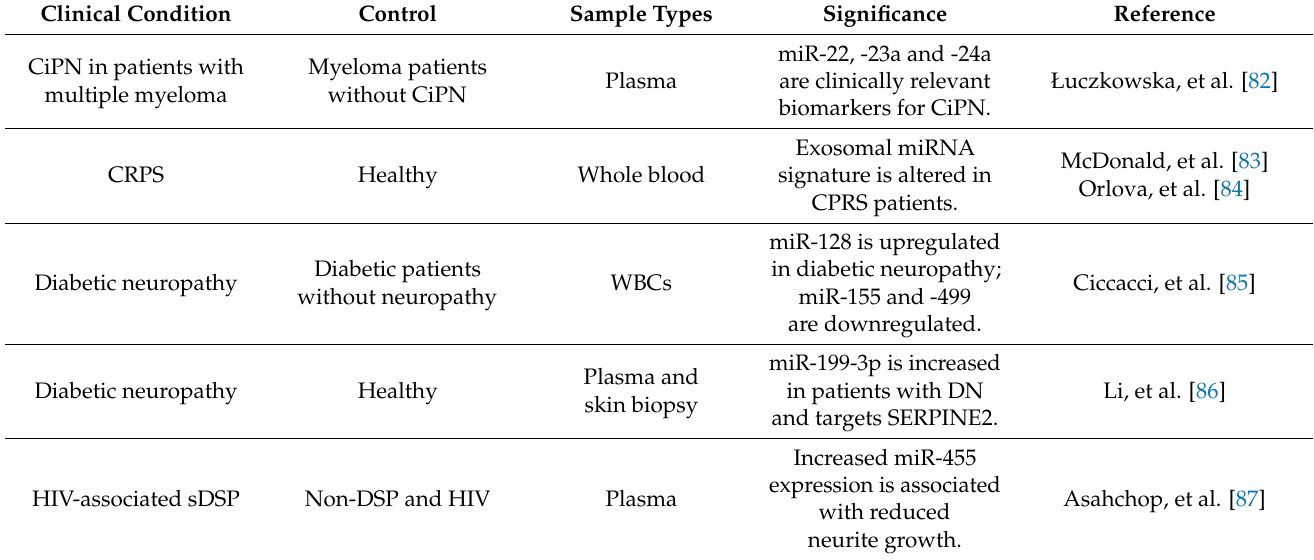
Table 2. List of studies on miRNA linked with chronic pain with a neuropathic component conducted on human samples. CRPS = complex regional pain syndrome, CiPN =